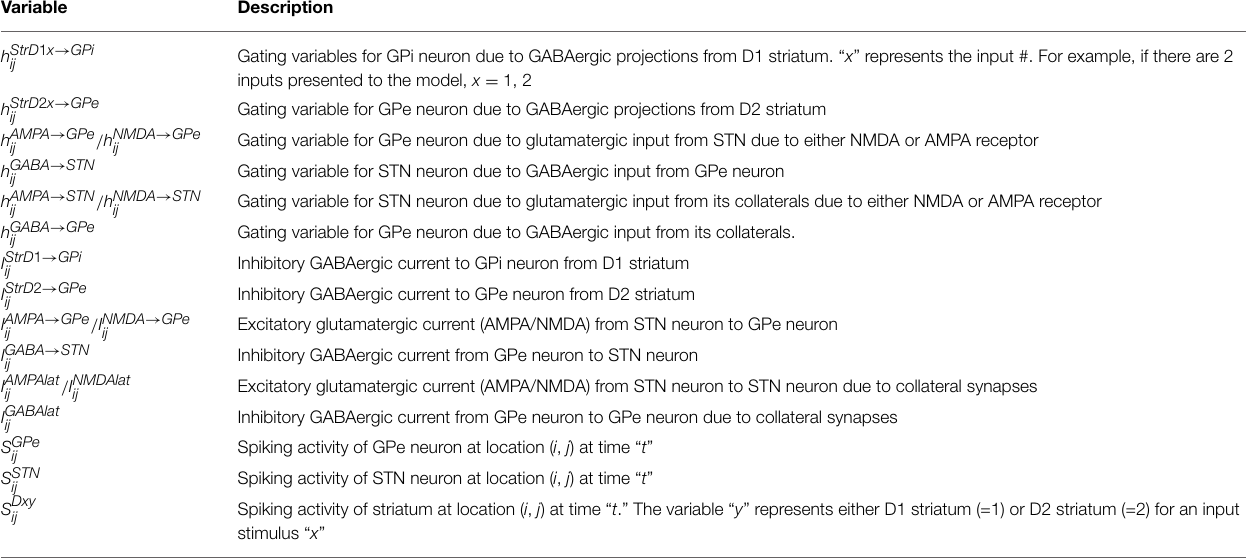
TABLE 2 | Gives a description of all the synaptic variables of various synaptic currents modeled using Equations (4) and (8) in Section Synaptic Connections. Variable